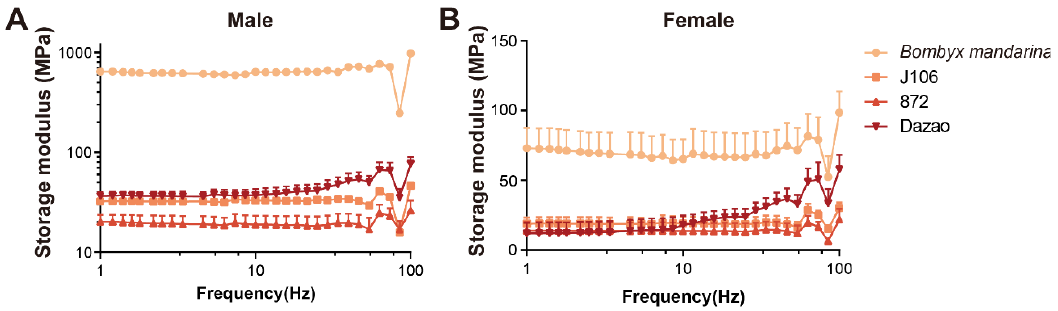
Figure 5. Mechanical properties of forewings. Storage modulus (E’) of forewings of the four populations in males ( A ) and females ( B ). The E’ of B. mandarina was higher than that of B. mori. Mean + SEM., n = 3 (wild male: n =